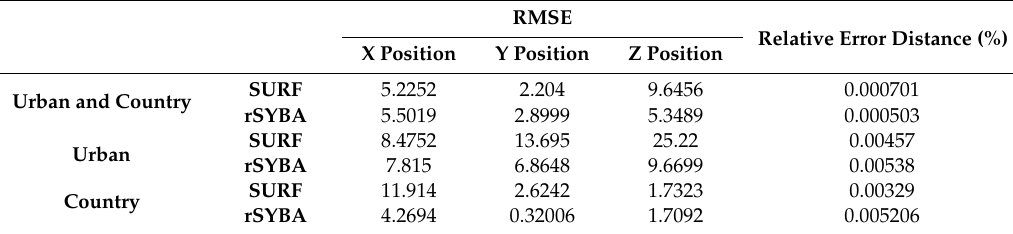
Table 4. The overall results for the RMSE between each frame the relative error in